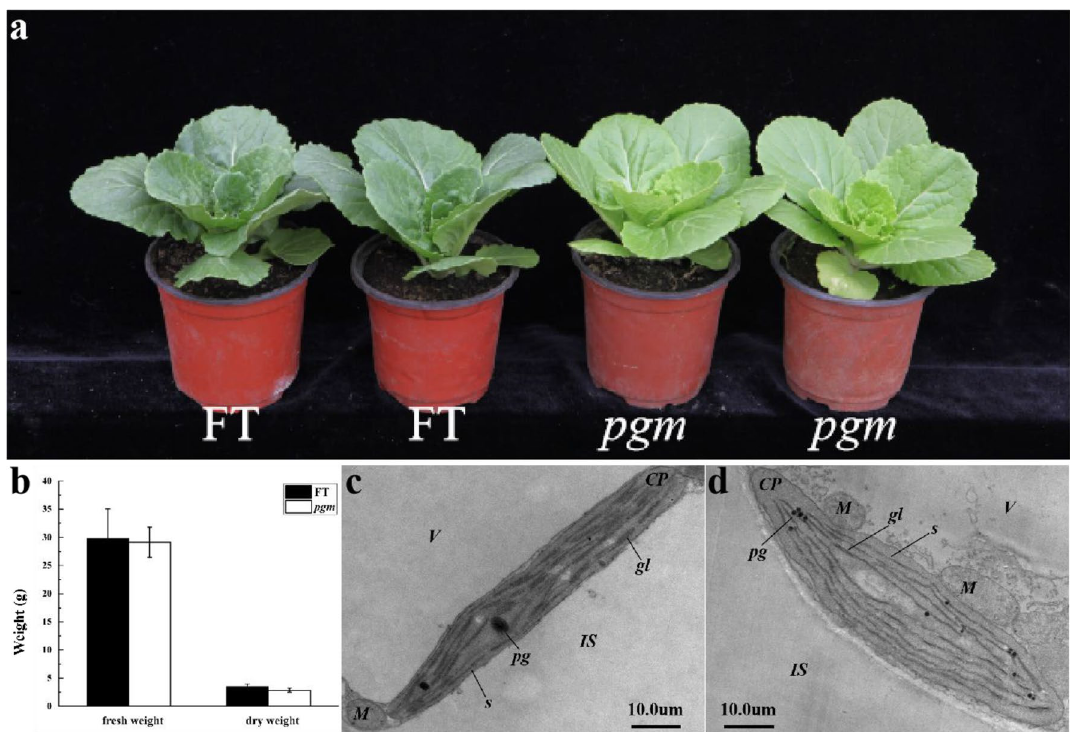
Figure 1. Phenotypic characterization and ultrastructure of chloroplasts of pale green mutant ( pgm ) and wild- type (FT). ( a ) Phenotypic characterization of pgm (right) and FT (left) at 6 weeks. ( b ) The fresh weight and dry weight in pgm and FT at 6 weeks. ( c , d ) Ultrastructure of chloroplasts in FT ( c ) and pgm ( d ). Scale is shown at the bottom.